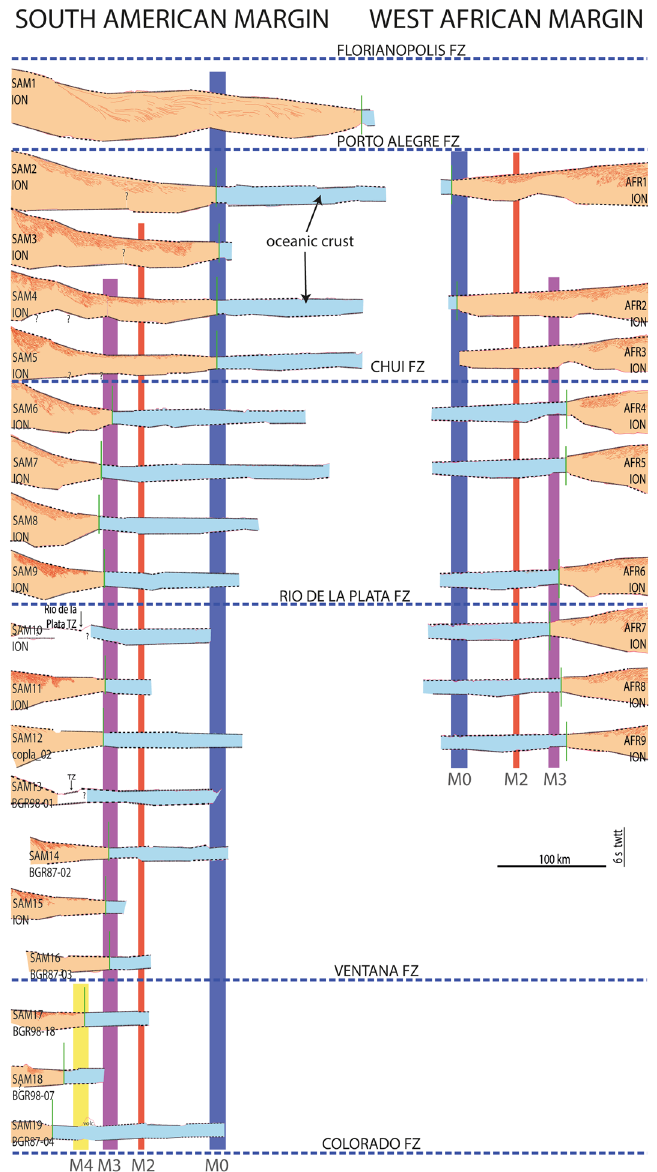
Figure 5. Synthetic view of all profiles used in this study. Light blue indicates oceanic crust. Orange indicates undifferentiated intruded and thinned crust, which may change gradually oceanward from unthinned continental crust up to highly intruded crust (hybrid crust) but is sketched here as a single type of crust for simplicity. Thin red line indicate SDRs. Vertical exaggeration of the seismic reflection profiles: ~ 2x. Seismic lines are aligned with respect to M2.o isochrone (vertical red line). Blue, red, purple and yellow vertical lines indicate M0.y, M2.o, M3.o and M4.o isochrones, respectively 30 . The blue dashed lines indicate fracture zones 39